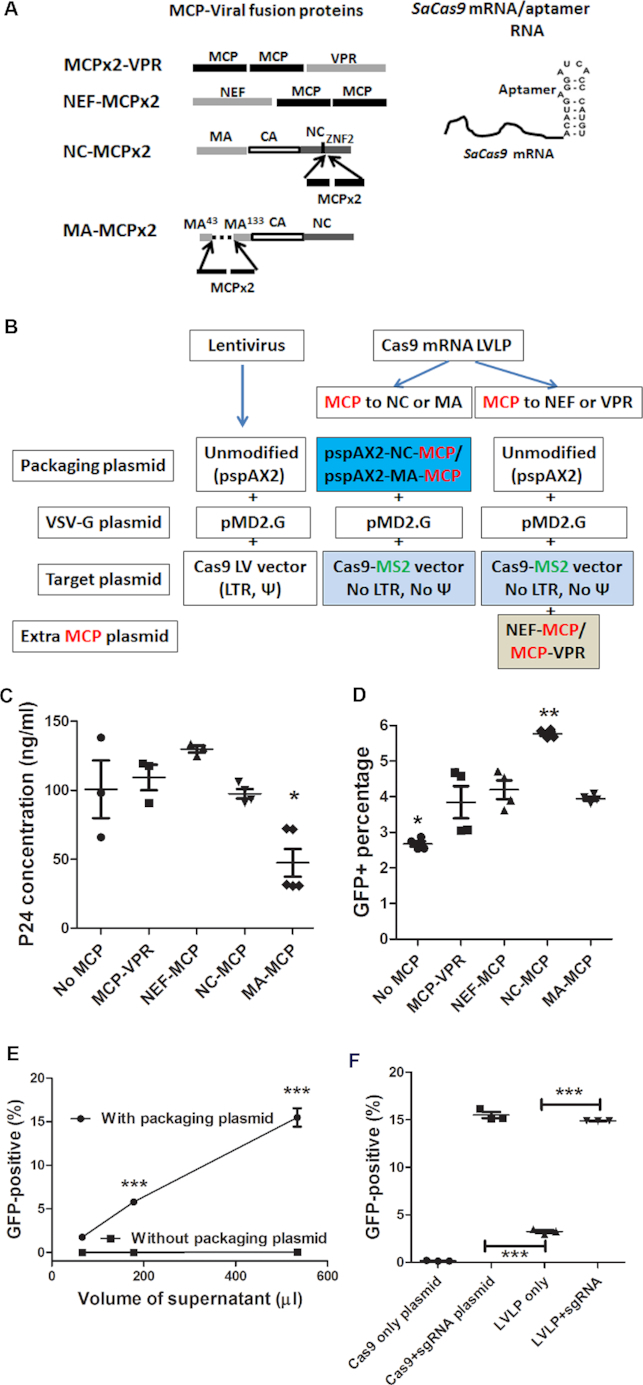
Developing LVLPs for SaCas9 mRNA packaging. (A) MCP-viral protein fusion proteins and SaCas9-MS2 aptamer fusion RNA for packaging SaCas9 mRNA in LVLPs. MCP: MS2coat protein; VPR: viral protein R, NEF: negative regulatory factor; NC, nucleocapsid protein; MA: matrix protein. Dashed line indicates the deleted region in MA. (B) Plasmids for making lentivirus and LVLP. The aptamer-binging protein MCP and the MS2 aptamer are shown in red and green respectively. LTR: long terminal repeats; Ψ: lentivirus packaging signal. (C) Effects of MCP-fusion proteins on lentivirus production. 5 × 105 cells in six-well plates were transfected with the indicated plasmids (5 μg total DNA). Twenty four hours after transfection the medium was replaced with 2 ml fresh medium and p24 was assayed after 24 h. Individual data points and mean ± SEM are shown. Only MA-MCP modification decreased virus production (P < 0.05). (D) Best gene editing activity was obtained when MCP was fused to NC. SaCas91xMS2 was expressed during LVLP production. 250 μl LVLP-containing supernatant and 250 μl IDLV-expressing HBB sgRNA1 were co-transduced into 2.5 × 104 GFP-reporter cells. ** indicates P < 0.01 when LVLPs from NC-MCP fusion was compared with other particles; * indicates P < 0.05 compared with any other particles. (E) Flow cytometry analysis of GFP reporter cells transduced with particles made with or without NC-MCP modified packaging plasmid. Increasing volumes of supernatants were co-transduced with 50 ng of HBB sgRNA1-expressing IDLV into GFP reporter cells. When producing particles without packaging plasmid, the packaging plasmid was replaced with pKanCMV-mRuby3-10aa-H2B expressing mRuby. ***P < 0.001 when the GFP-positive rates of the two conditions were compared (Bonferroni posttests following ANOVA). (F) Plasmid DNA contributed little in generating GFP-positive reporter cells. pSaCas91xMS2 (first column) or pSaCas91xMS2-HBB sgRNA1 plasmid DNA (second column) was transfected into GFP reporter cells to observe GFP-positive cells. pSaCas91xMS2-HBB sgRNA1 was also used to make LVLPs to transduce into GFP reporter cells alone (100 ng p24, the third column) or with 50 ng p24 of IDLV expressing HBB sgRNA1 (the fourth column). *** indicates P < 0.001. For C, D and F, Tukey's multiple comparison tests were performed following ANOVA analysis.